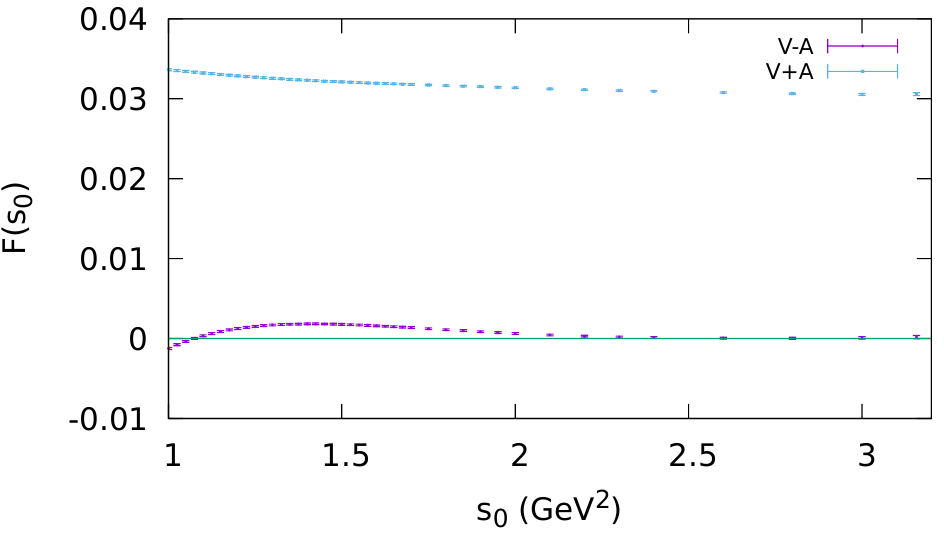
Figure 3 . F V ± A ( s 0 ) as defined in eq. (5.5). The upper and lower curves correspond to V + A and V − A ,